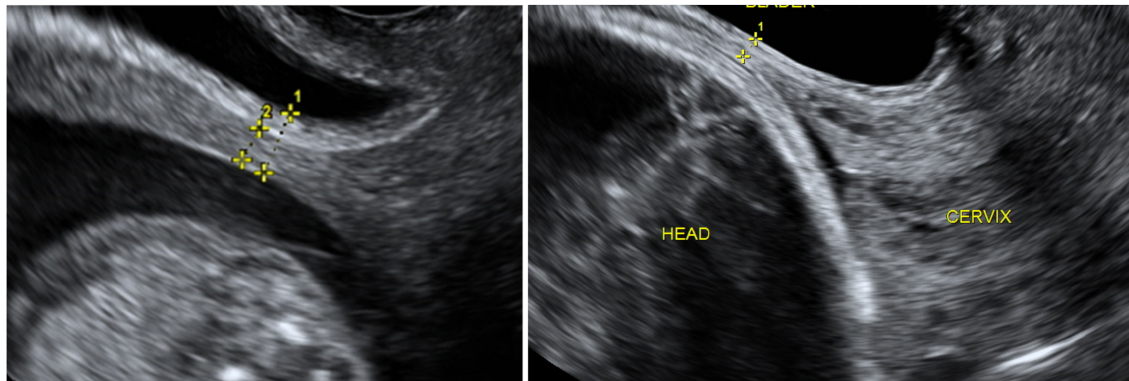
Figure 2. The full low uterine segment thickness (1) (one caliper is placed at the interface between urine and the bladder wall, another is placed at the interface between amniotic fluid (or fetal scalp) and the deciduas); Myometrial LUS thickness (2) (one caliper at the interface of the bladder wall and the myometrium, so includes only hypoechogenic layer) at the second trimester of pregnancy (on the left ); and full LUS thickness (1) at the third trimester of pregnancy (on the right ), measured by transvaginal